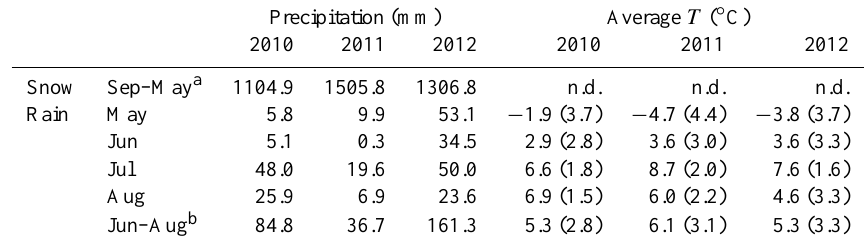
Table 2. Cumulative precipitation and mean air temperature ( ± SD) at Thule airport (THU) for the measurement period. Precipitation